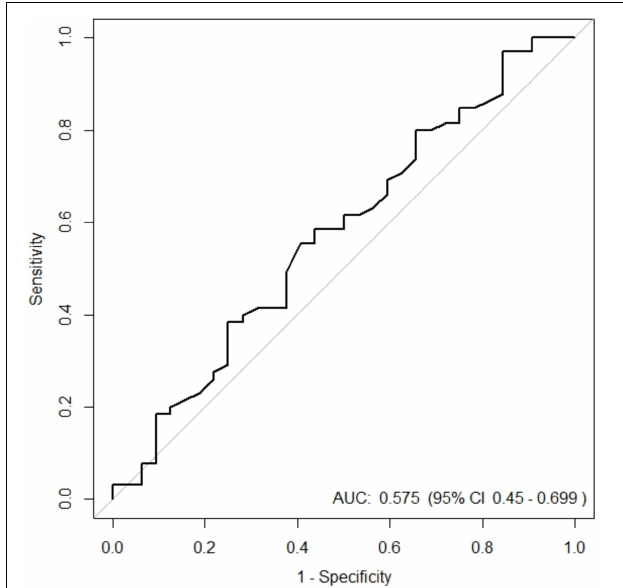
FIGURE 2 | Empirical ROC curve of Optic Nerve Sheath Diameter (ONSD) used to diagnose an intracranial hypertension occurring within the first 24 h following the measurement of ONSD in a paediatric brain injury population. AUC, area under the curve.